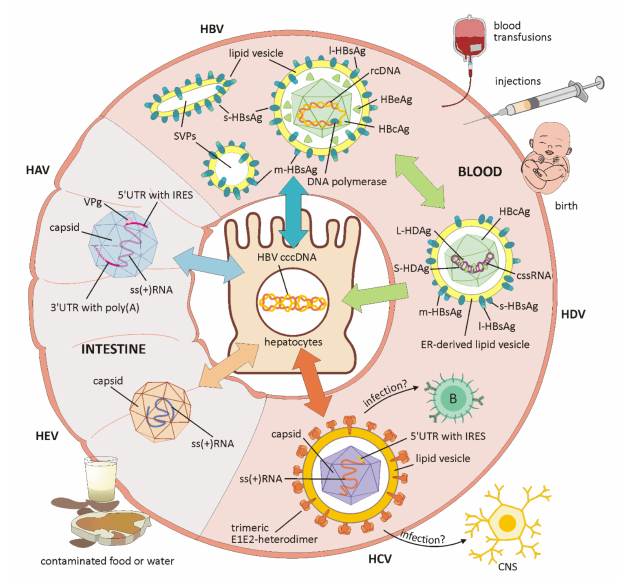
Figure 1. Structure and ways of transmission of the hepatitis viruses A, B, C, D and E. While HAV and HEV are enterically transmitted by contaminated water or food and mainly cause acute hepatitis, HBV, HDV and HCV are blood-borne infections, which are responsible for chronic disease development in many cases. (HAV) HAV has a single-stranded RNA genome encoding a polyprotein, which is translated 5 (cid:48) cap-independently under the control of an IRES. The 5 (cid:48) UTR is linked to VPg and the 3 (cid:48) UTR ends with a poly(A) tail. The virion exists as a non-enveloped form in the stool (as depicted here) and as eHAV in the blood of infected patients (not shown). (HBV) HBV exclusively infects liver cells and is packed in a lipoprotein envelope containing small, medium and large surface proteins. The core protein builds up a nucleocapsid containing partially double-stranded DNA (rcDNA) with an associated polymerase. In addition to viral particles, pre-core protein (HBeAg), and high amounts of non-infectious SVPs containing only envelope proteins are secreted. Inside the nucleus of infected hepatocytes, the HBV genome is converted to cccDNA, which remains stable in form of a mini chromosome or episome serving as a genomic template for viral mRNA synthesis. (HDV) HDV is known to infect hepatocytes and has a css(-)RNA that codes for only one viral protein in two forms, a small (S-HDAg) and a large (L-HDAg) viral antigen. By base-pairing, the genomic RNA has a rod-like structure and is associated with S-HDAg and L-HDAg, forming an RNP. In order to form virus particles, HBsAg envelope proteins of the HBV virus are embedded in an ER-derived lipid vesicle. (HCV) HCV is an enveloped virus with a single positive-stranded RNA encoding a polyprotein, which is subsequently cleaved into 3 structural and 7 functional proteins. It primarily infects hepatocytes, but HCV-RNA has been detected in peripheral blood cells, cerebrospinal fluid and in the brain of patients with chronic infection. Two envelope glycoproteins, E1 and E2, form trimeric heterodimers in the host-derived lipid envelope and are the main target of neutralizing antibodies during immune response. (HEV) HEV is mainly transmitted by contaminated food or water and replicates in the liver. In the stool and in the liver, it occurs as envelope-free virus with an ss(+)RNA encoding an enzymatic polyprotein and structural proteins. In the blood of infected patients, it can be detected as eHEV virion (not shown). Abbreviations (in alphabetical order): B = B lymphocyte; cccDNA = covalently closed circular DNA; CNS = central nervous system; css(-)RNA = circular single negative-stranded RNA; eHAV = quasi-enveloped hepatitis A virus; eHEV = quasi-enveloped hepatitis E virus; ER = endoplasmic reticulum; HBcAg = hepatitis B core antigen (capsid protein); HbeAg = hepatitis B e antigen (precore protein); IRES = internal ribosomal entry site; l-HbsAg = large hepatitis B surface antigen; L-HDAg = long hepatitis D antigen; m-HbsAg= medium hepatitis B surface antigen; rcDNA = relaxed circular DNA; RNP = ribonucleoprotein; s-HbsAg = small hepatitis B surface antigen; S-HDAg = short hepatitis D antigen; ss(+) RNA = single positive-stranded RNA; SVPs = subviral particles; UTR = untranslated region; VPg = viral protein